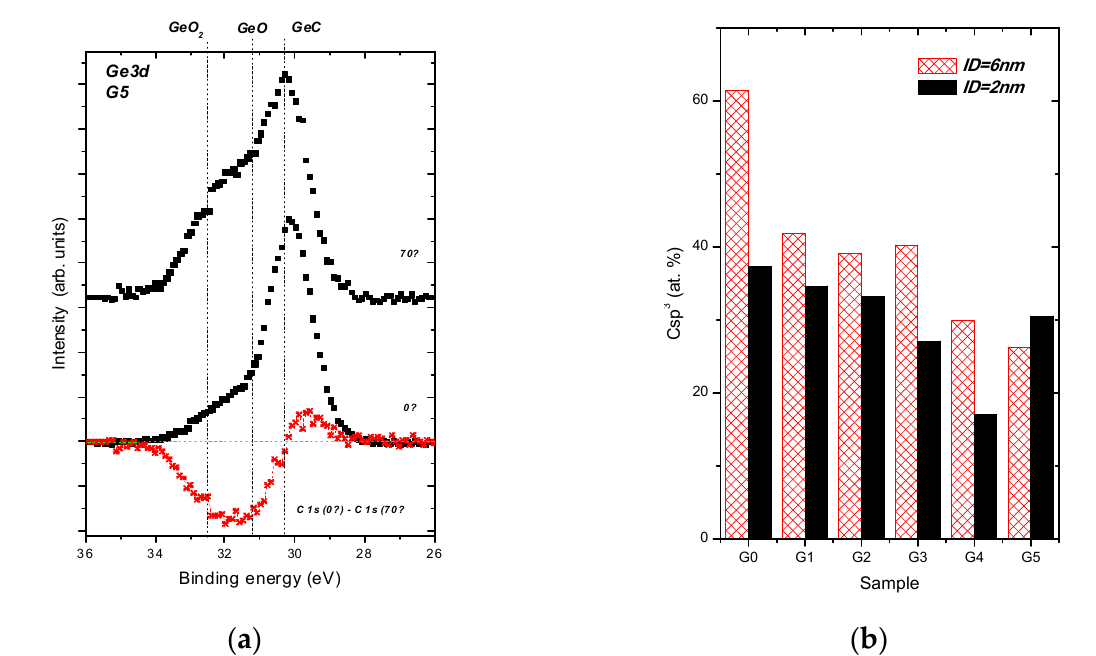
Figure 4. Typical Ge 3d spectra recorded from the DLC:Ge sample G5 at the normal emission angle (ID~6 nm), at the inclined emission angle (ID~2 nm) and their difference ( a ). Content of C sp 3 contributions for all analysed samples fitted from the C 1s spectral envelopes recorded at the normal and the inclined emission angles and therefore at two different IDs ( b